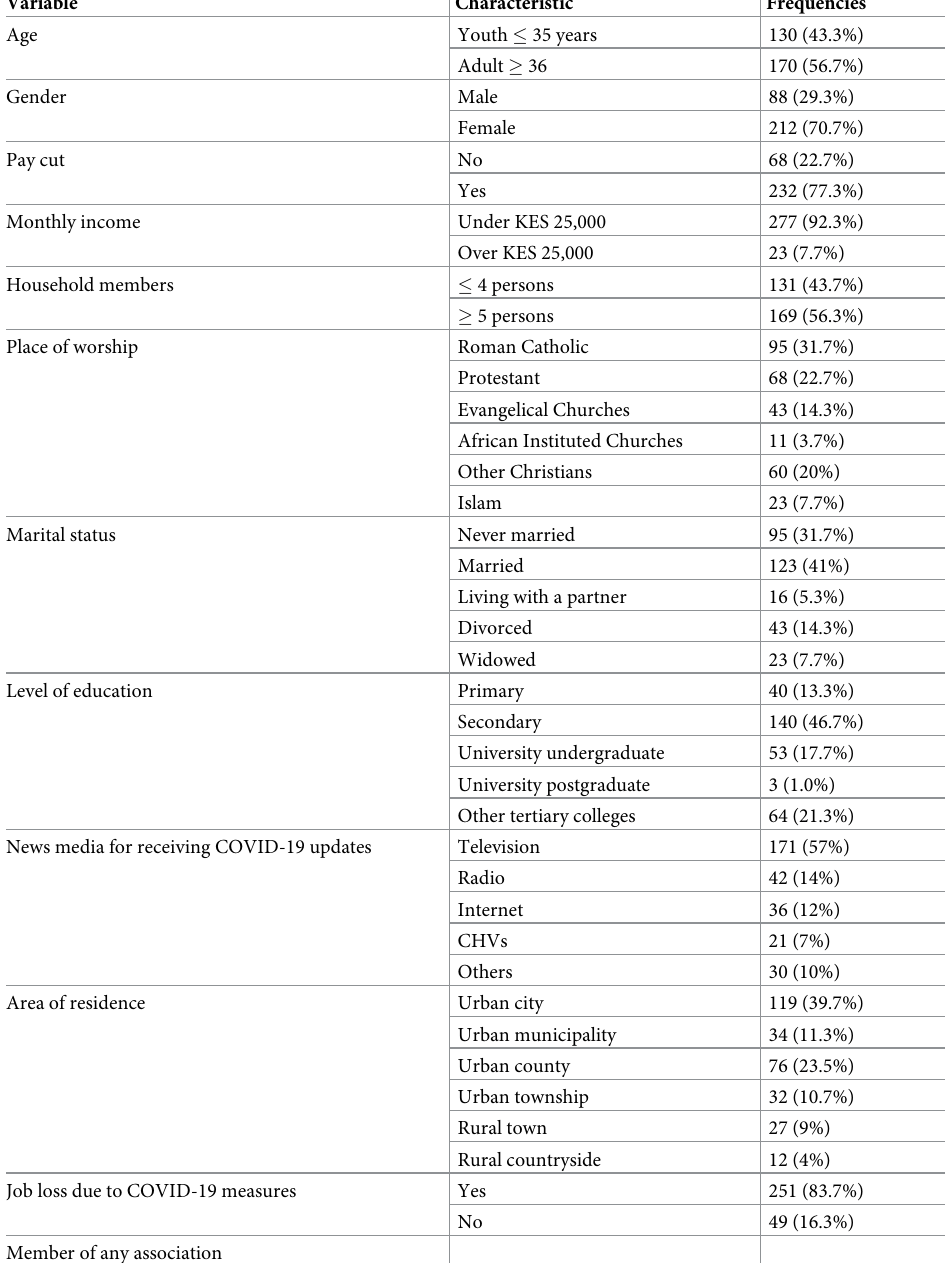
Table 1. Descriptive